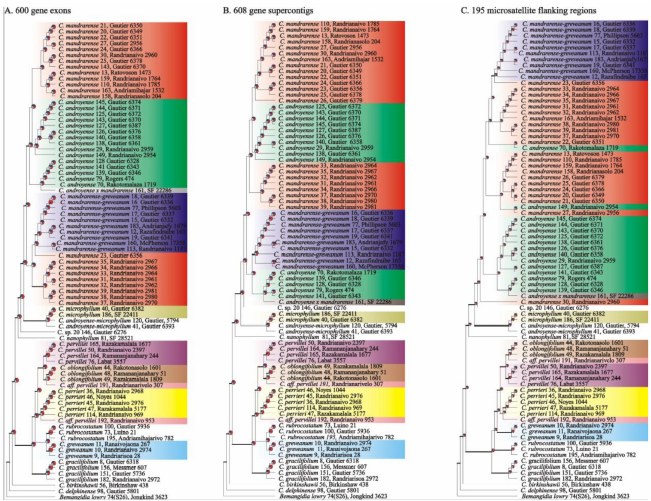
Figure 3. Pseudocoalescent ultrametric phylogenetic tree from Astral inferred from RAxML analyses of ( A ) 600 gene exonic regions, ( B ) 608 gene supercontigs including introns, exons and flanking regions and ( C ) 195 microsatellite flanking regions. All specimens contained less than 20% missing nucleotide positions. Colors refer to morphospecies. Pie charts represent the proportion of gene trees that support the clade of interest (red), support the main alternative bifurcation (blue), or support any other remaining alternative solution (gray). Astral posterior probabilities higher than 0.8 are depicted only for interspecific clades as bold lines. Species names are followed by the specimen number used in this study and the collector